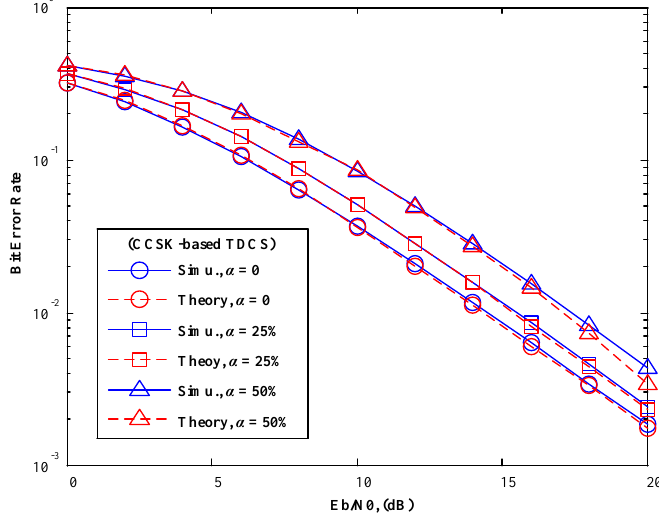
Figure 9. BER performance of TDCS-CCSK in multi-path channels (various mismatch factor α). Sensors 2017 , 17 , 1593